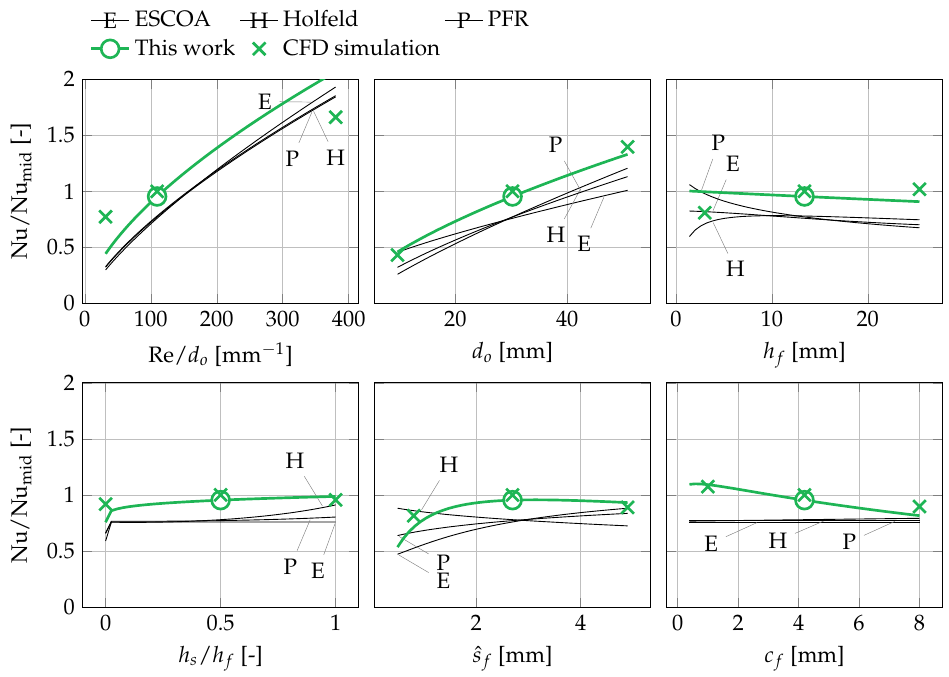
Figure 6. Trends in correlations and CFD simulator around the midpoint in the design space (marked by a circle). CFD simulations were independently sampled (not part of the dataset used for model development). Each parameter was varied independently, with remaining parameters held constant.